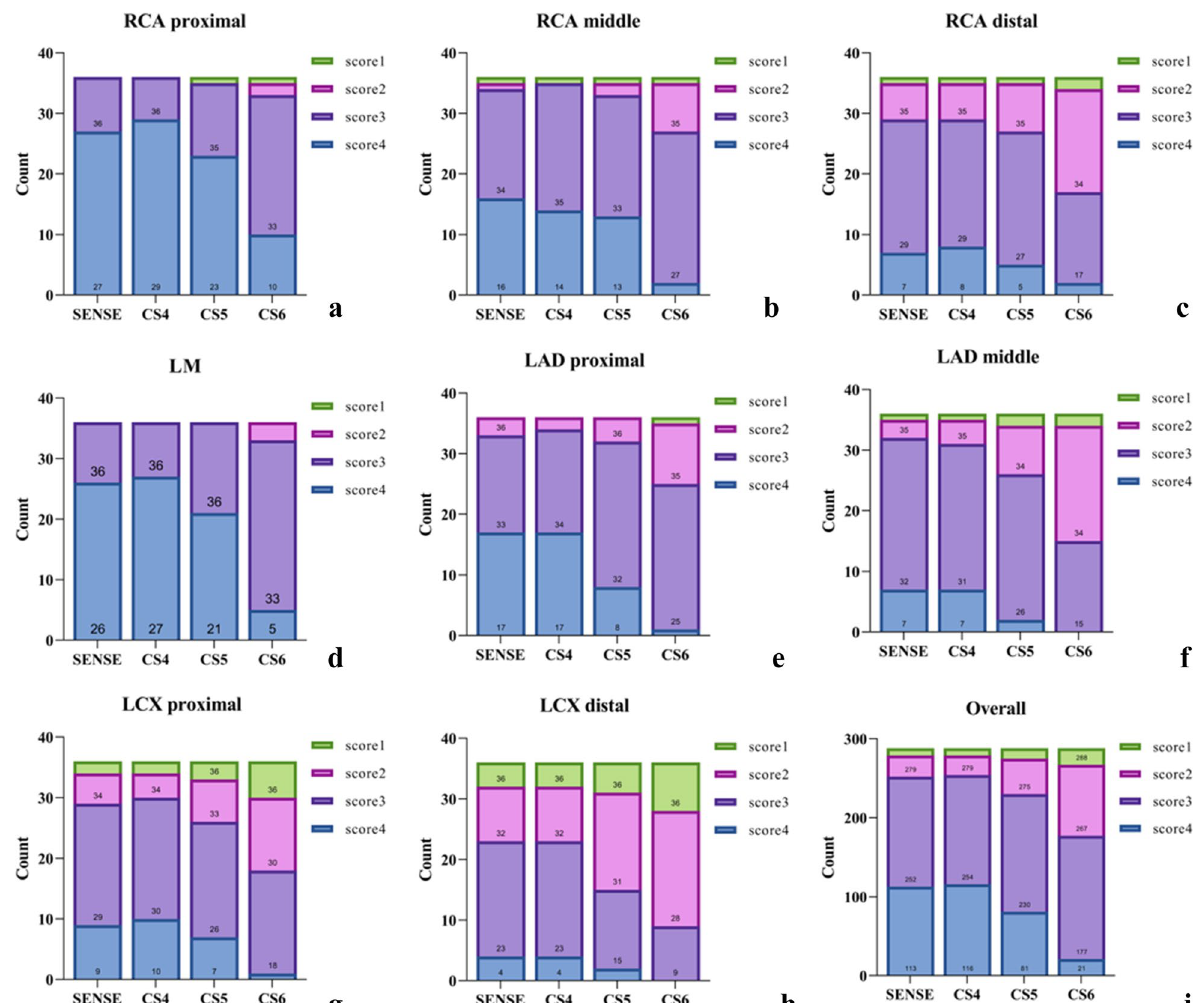
Fig. 8 Stacked graphs of coronary artery segments ( a – h ) and overall image quality scores ( i ). No significant differences were observed between SENSE and CS4 sequences ( p >